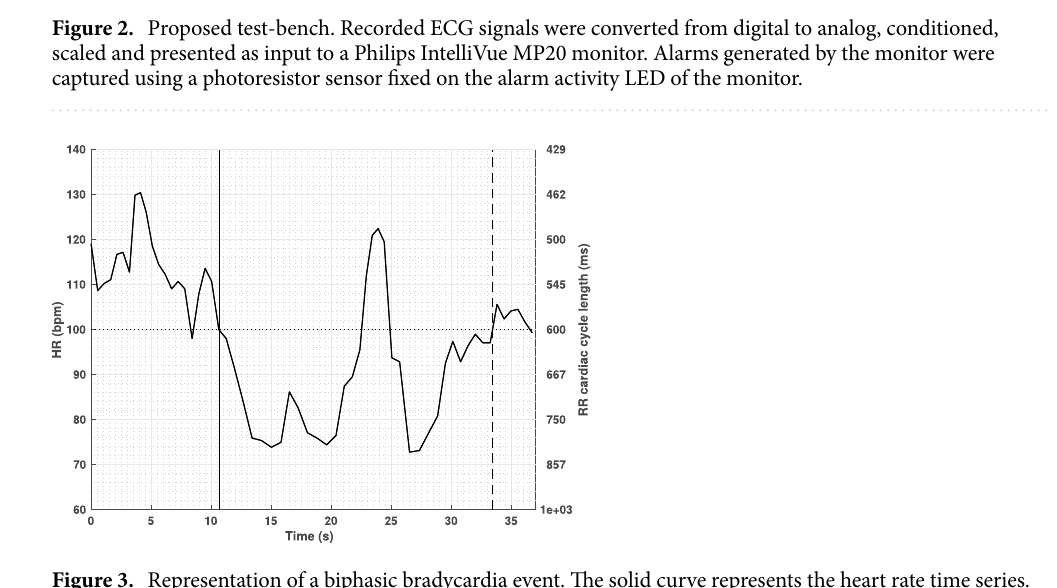
Figure 3. Representation of a biphasic bradycardia event. The solid curve represents the heart rate time series. Horizontal dotted line represents the 100 bpm threshold (Yellow alarm). The vertical solid line represents the beginning of the bradycardia and the vertical dashed line represents the end of the event, as annotated by clinicians. During this bradycardia episode, the heart rate was higher than 100 bpm during a short time period (less than 10 s). We consider this event as one single biphasic